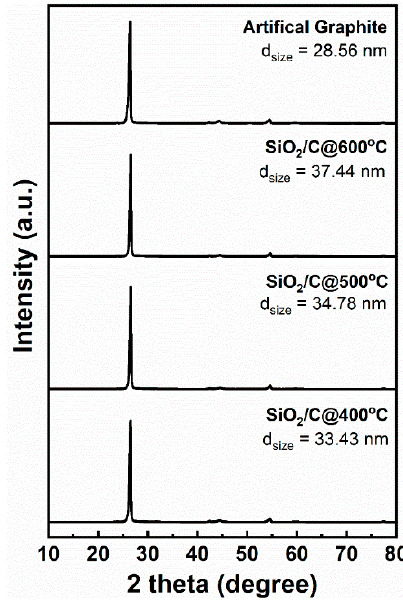
/ C heated at 400, 500, and 600 ◦ 2